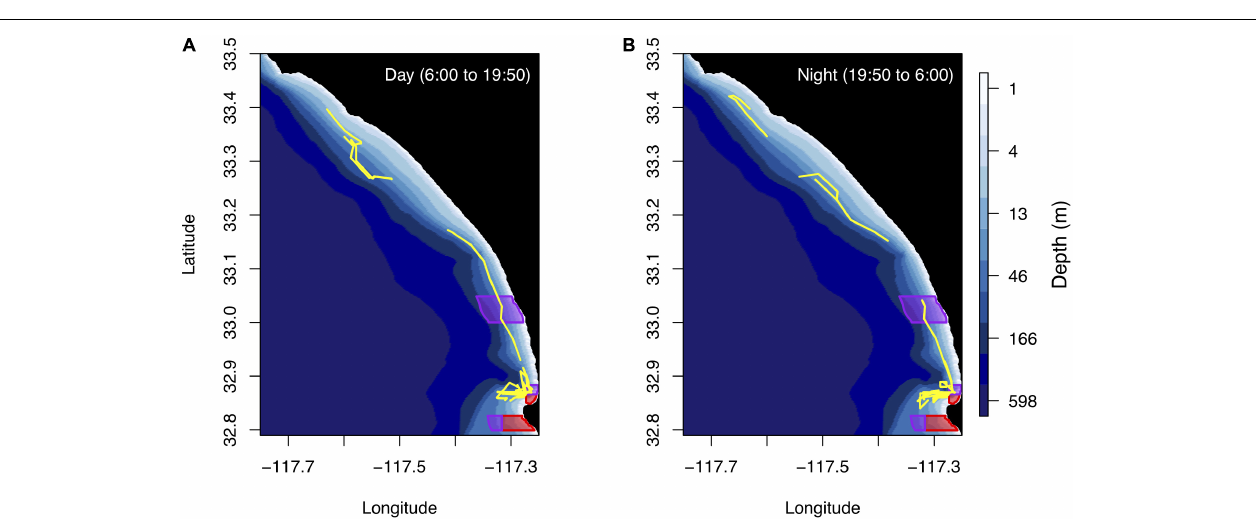
FIGURE 3 | (A) The Wave Glider track during the day from sunrise to sunset. (B) The Wave Glider track during the night from sunset to sunrise. Note, some areas were not sampled during both the day and night. Bathymetry along the Wave Glider track (yellow line) from La Jolla Cove, San Diego, to Capistrano Beach, CA and California SMR and SMCA within the study area are shown in red and purple, respectively. Average sunset and sunrise times are also shown on the maps. Times are reported in Pacific Standard